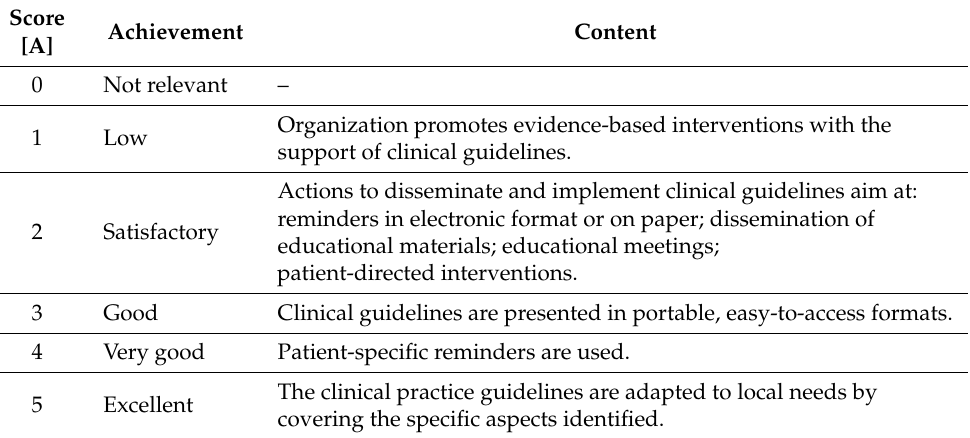
Table A8. Scale for indicator IA32—Practice guidelines employment and